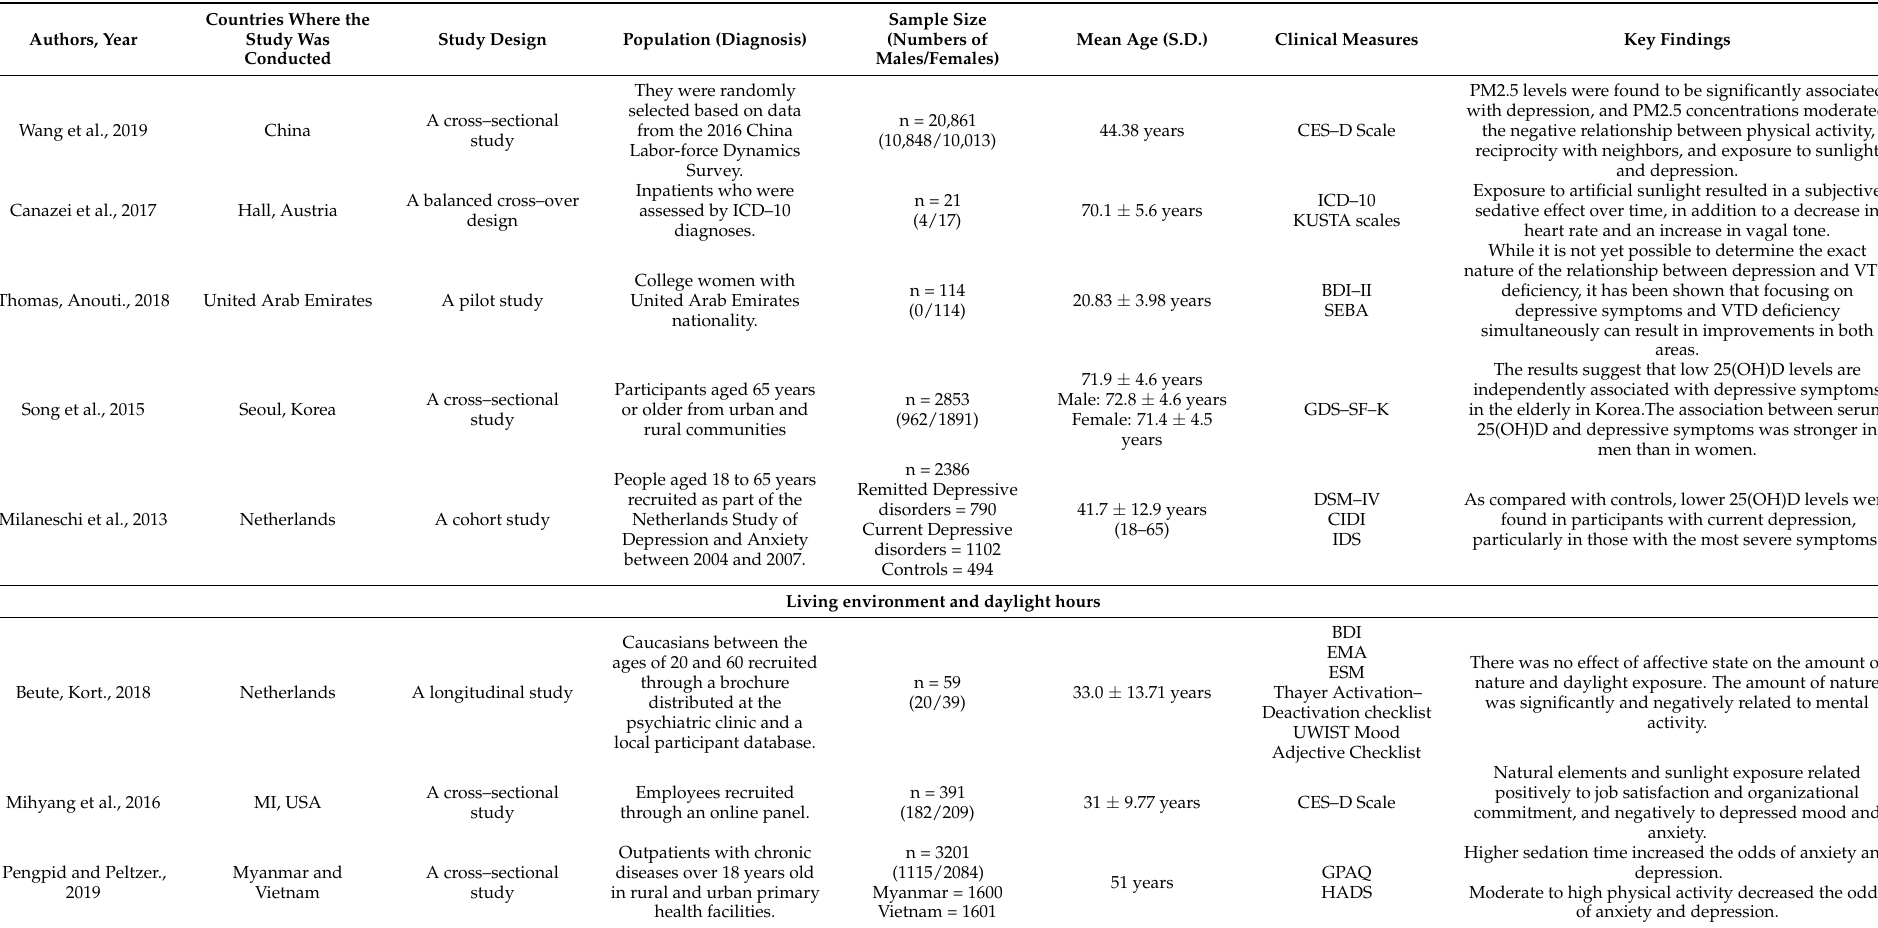
Table 2. Internal factors including lifestyle and physical